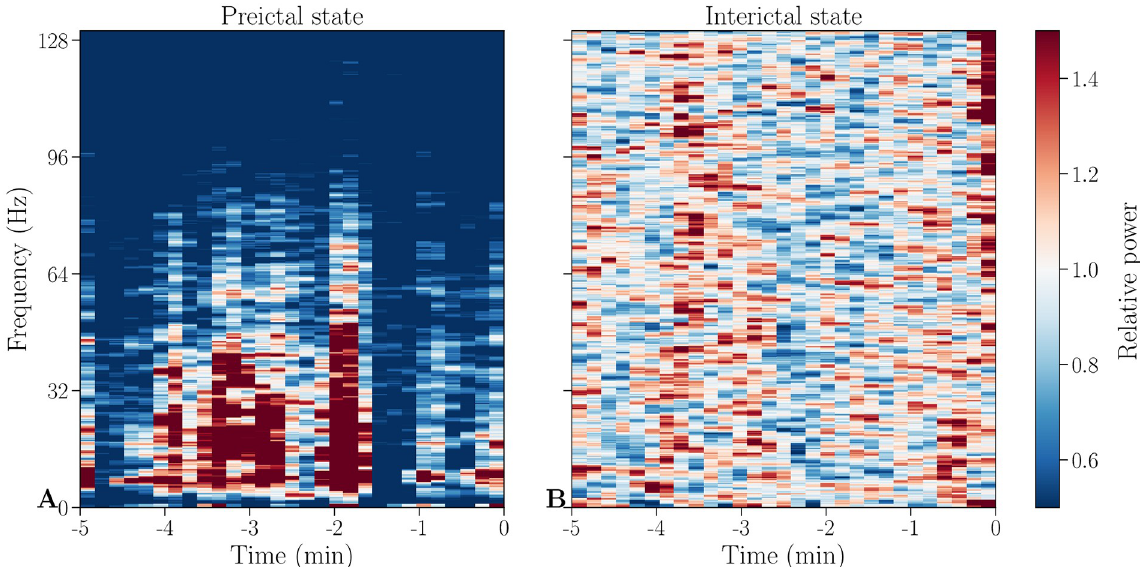
Fig 1. Example spectrograms of preictal and interictal states. Baseline corrected spectrograms of a preictal ( A ) and an interictal ( B ) individual measurement period of channel HR1 from patient 1. This channel and individual measurement period will be used throughout the paper for illustrative purposes, if not stated